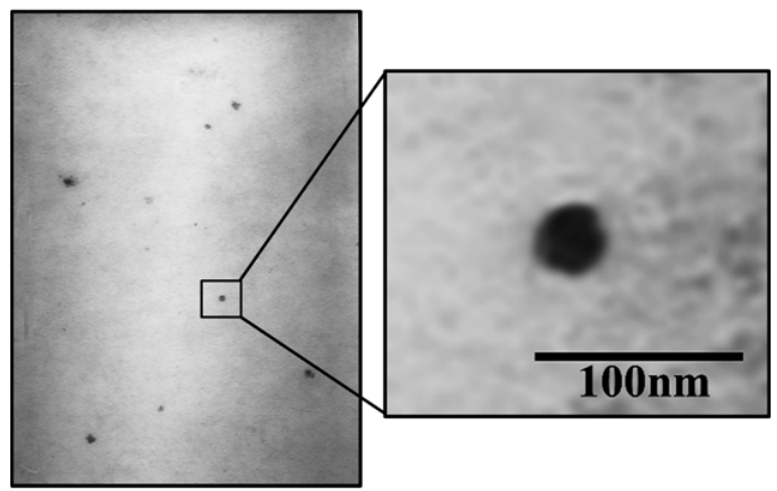
Figure 5. TEM image of the α -mangostin-loaded USUC (30,000-fold magnification).